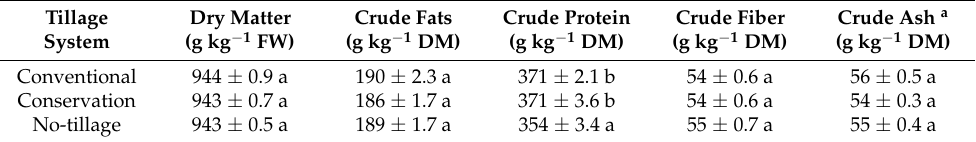
Table 5. Nutritional composition of the soybean seeds according to the different tillage